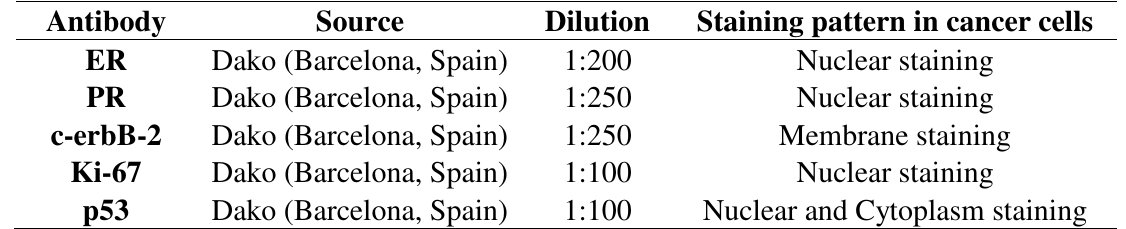
Table 2. Antibodies used in the Immunocytochemical and Indirect Immunofluorescence analysis.